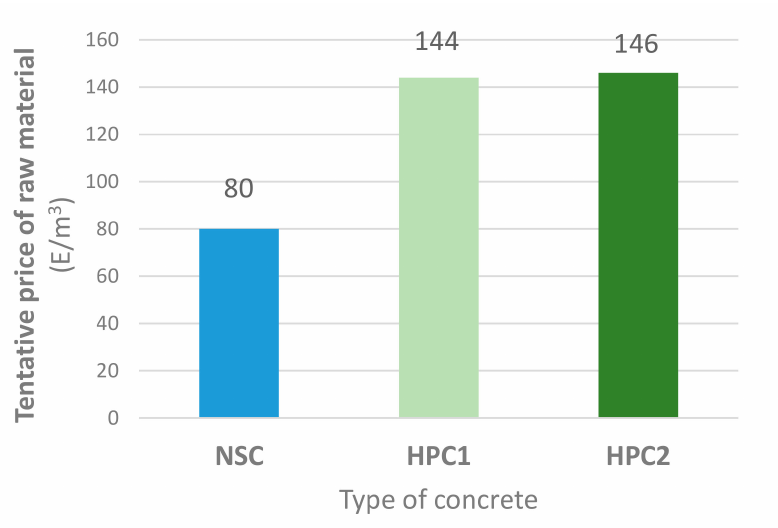
Figure 12. Comparison of tentative raw material price of NSC and variants of